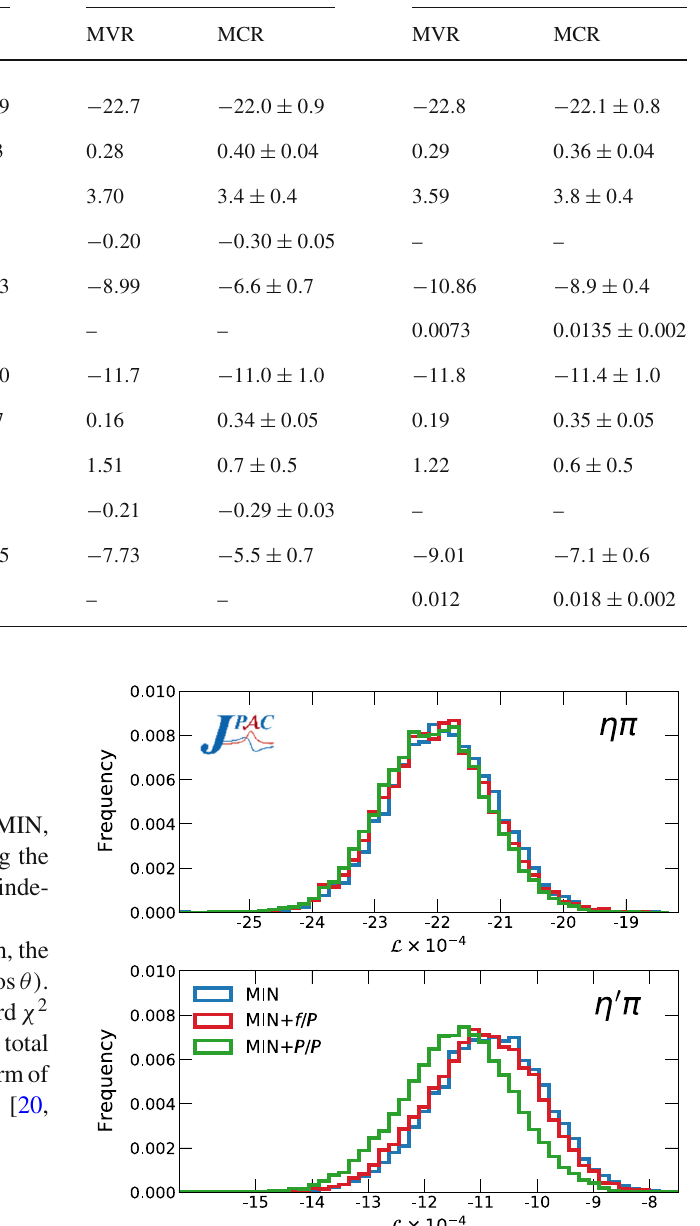
Table 1 ENLL and fit parameters { c } (in appropriate GeV units) for both MVR and MCR. For MVR, L corresponds to the best fit found, while for MCR the value and error of L correspond to the mean value Channel